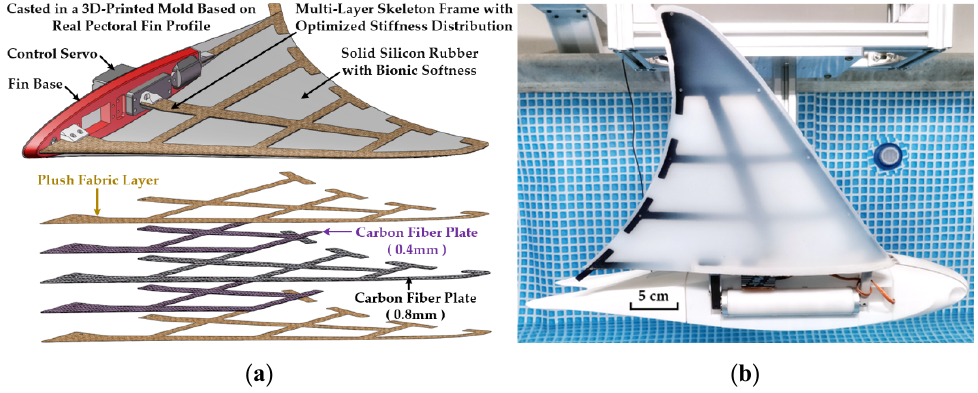
Figure 4. The pectoral fin module with 3D profile and bionic softness. ( a ) Sandwich structure of the fin skeleton frame; ( b ) Photo of the finished bionic soft fin module.